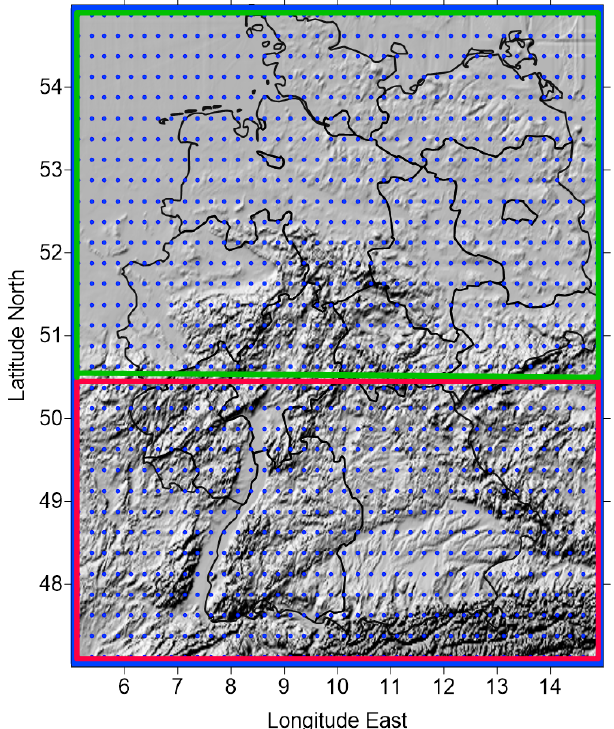
Figure 6. Relief map of Germany with the GE region (blue frame) and the subregions GES (southern Germany; red frame) and GEN (northern Germany; green frame) considered in this study. The E- OBS grid is marked by blue dots.